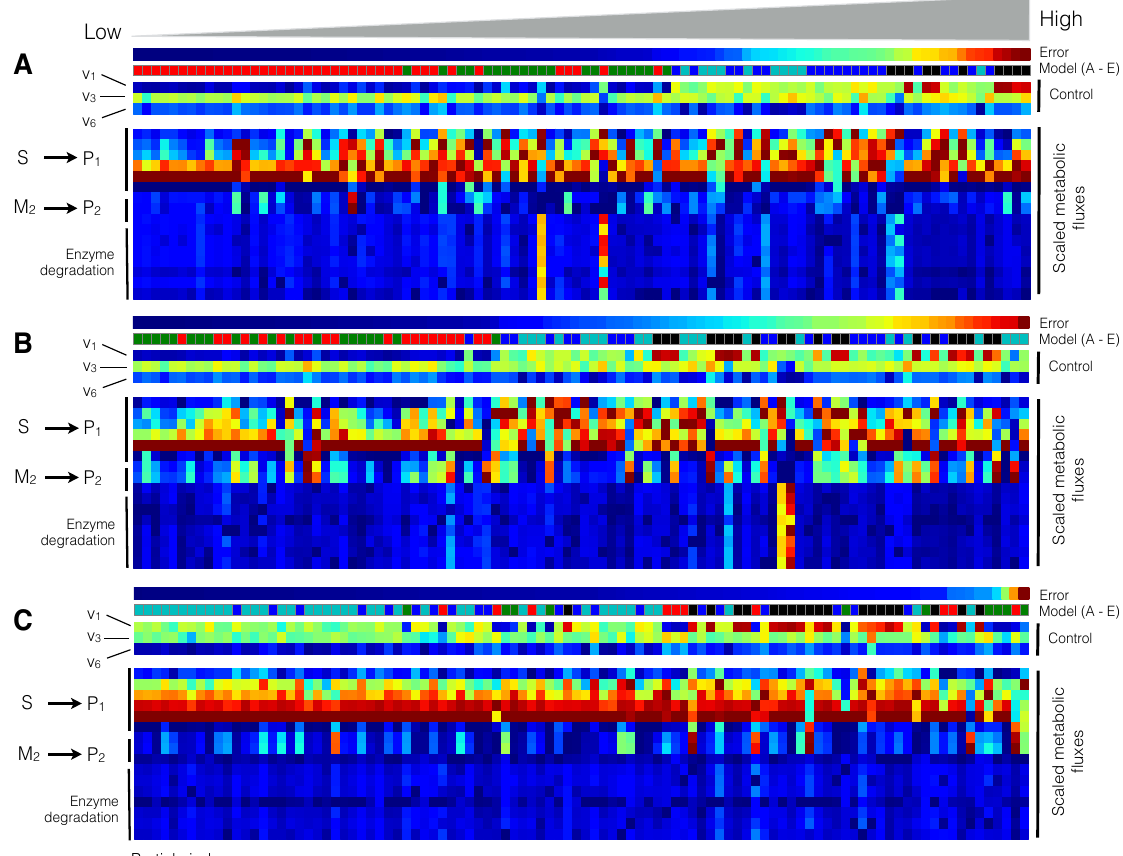
Figure 8. Metabolic flux and control variables as a function of network type and particle index at t = 100 min. The particle error, the control variables governing E , v activity ( v and v ) and the scaled metabolic flux were calculated for the positively 1 3 3 (top), uniformly (middle) and negatively (bottom) biased particle swarms ( N = 100). Blue denotes a low value, while red denotes a high value for the respective quantity being plotted. The particles from each swarm were sorted based upon simulation error (low to high